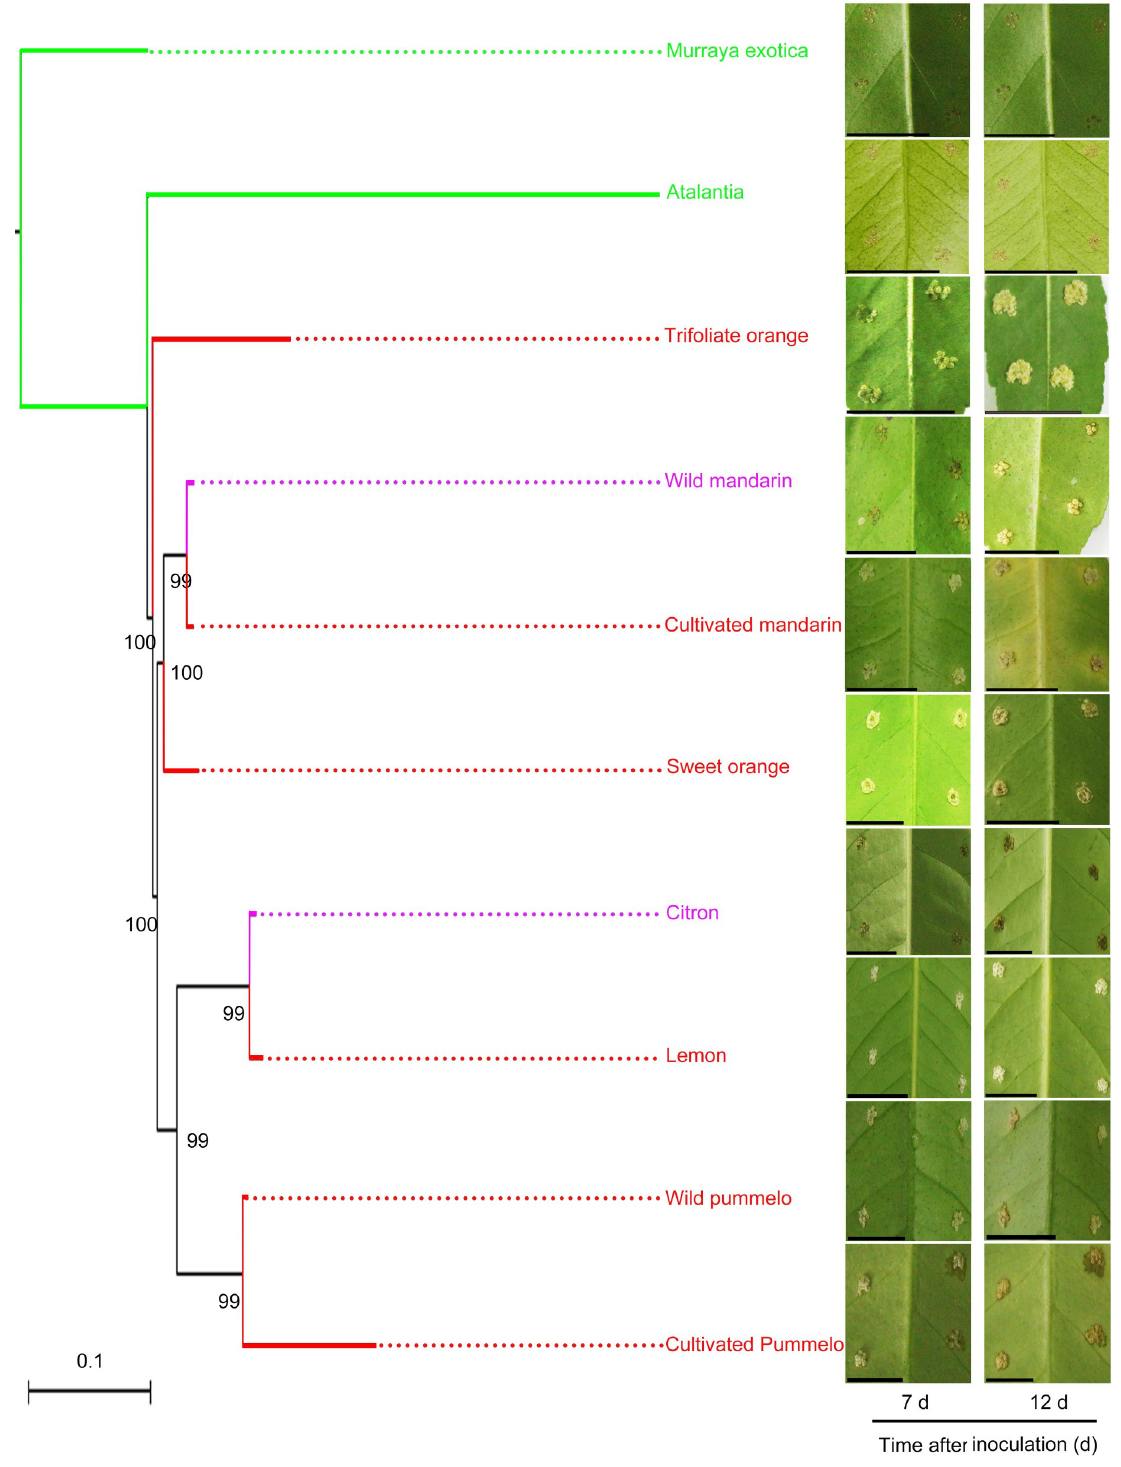
Fig 1. Atalantia buxifolia resistance to citrus canker. The phylogenetic tree was constructed by using the maximum likelihood tree method and the substitution model GTRGAMMA in the RAxML software. Murraya koenigii was used as the outgroup. Fully expanded leaves were treated with Xcc (10 8 CFU/mL) to evaluate citrus canker resistance. The symptoms were observed at 7 and 12 d after inoculation. Red indicates canker susceptible citrus (Wild pummelo: purple pummelo; Cultivated pummelo: guanxi pummelo;